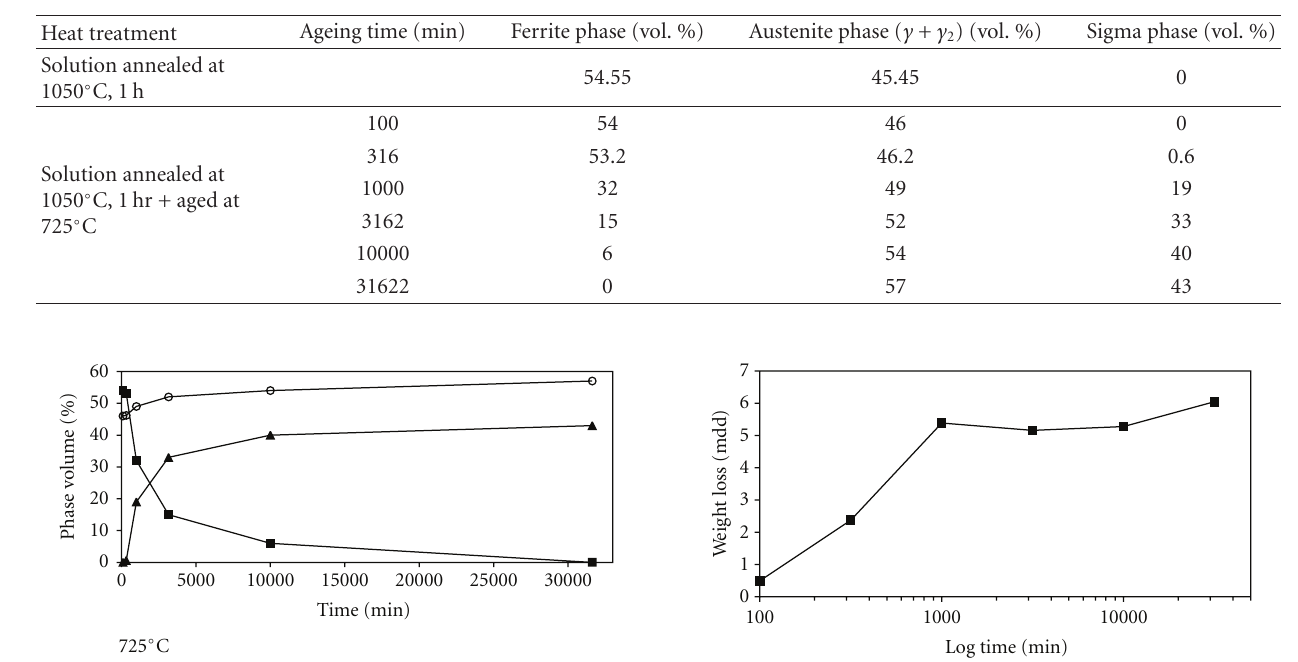
Table 2: The phase volume percentages obtained from digital image analysis.